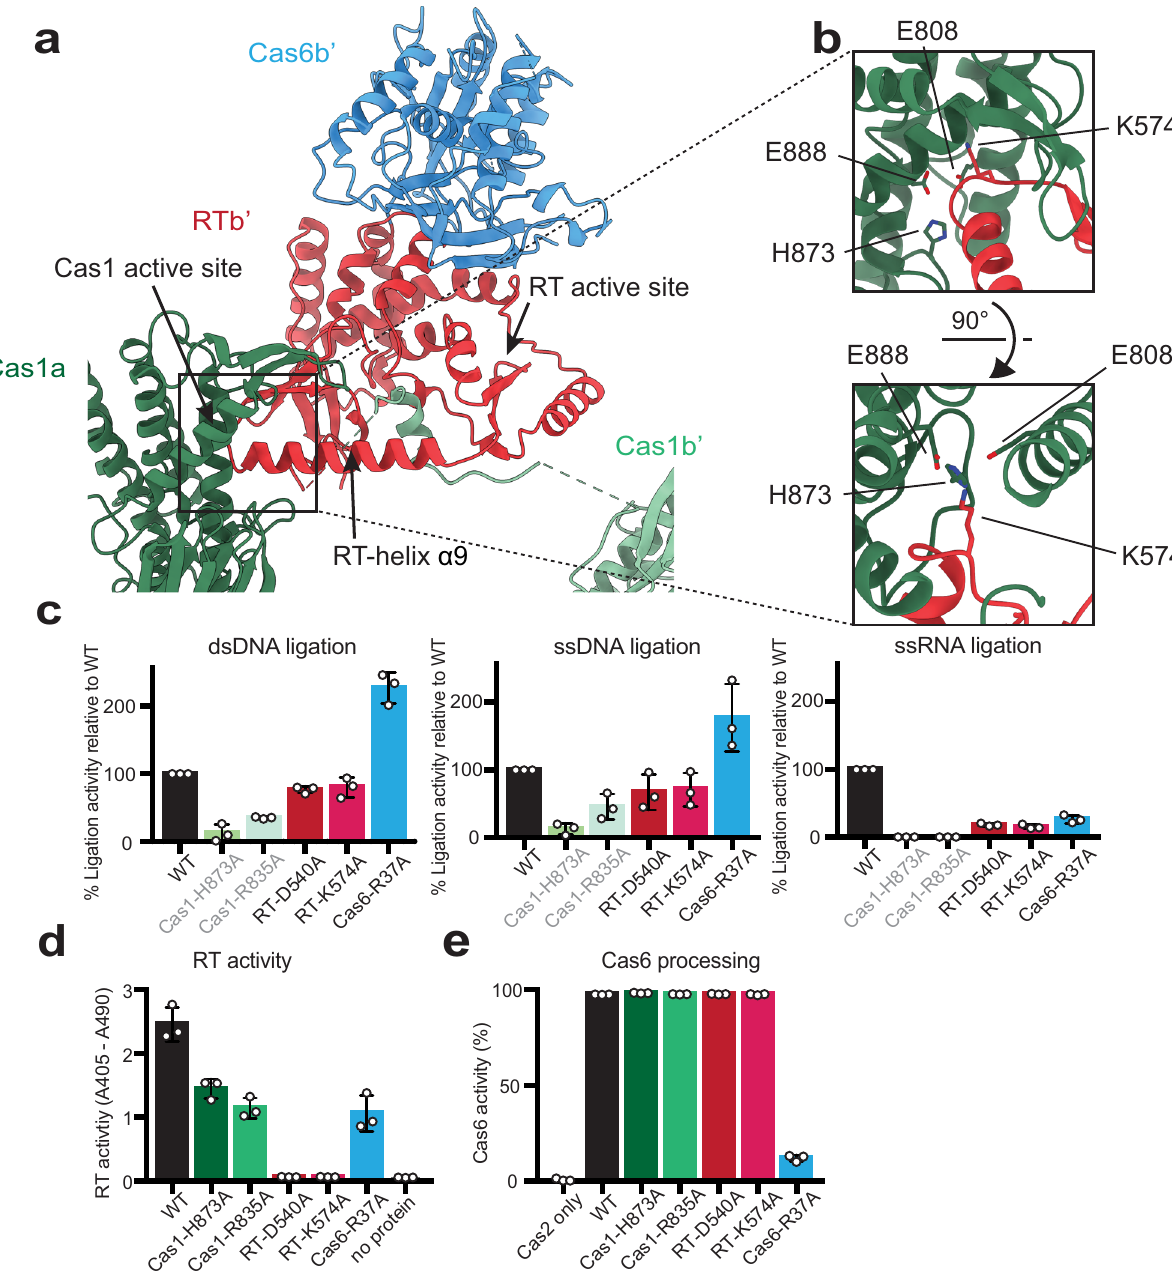
Fig. 6 Crosstalk between RT and Cas1 and Cas6 active sites. a Interaction between RT-helix α 9 and Cas1 active site (color-coding from Fig. 1). b Closeup of RT-helix in Cas1a and 90° rotation. Cas1 active site residues and RT-helix K574 are shown in stick con fi guration. c Ligation of fl uorescent 35-nt dsDNA (0.5 µ M), ssDNA (0.5 µ M), and ssRNA (4 µ M) protospacers into target pCRISPR by mutant Cas6-RT-Cas1 — Cas2s. The percent ligation activity is calculated as the fraction of fl uorescent products from the mutant complex relative to that from the WT complex (error bars, mean ± sd, n = 3 biologically independent experiments). Results are represented by colored bars: WT, black; Cas1 mutants, greens; RT mutants, reds; Cas6 mutant, blue. Cas1 mutant data are the same data shown in Fig. 2e and are depicted in pale greens with gray labels. Representative gels are shown in Supplementary Fig. 8c. d RT activity assays comparing the WT and mutant Cas6-RT-Cas1 — Cas2s (error bars, mean ± sd, n = 3 biologically independent experiments; Catalog No. 11468120910, Roche Diagnostics, Indianapolis, IN). Statistical signi fi cance was assessed by comparing samples to WT control using unpaired, two-tailed T tests ( α = 0.05) ( P = 0.0048, Cas1-H873A; P = 0.0019, Cas1-R835A; P = 0.0001, RT-D540A; P = 0.0001, RT-K574A; P = 0.0034, Cas6-R37A). Same color-coding is used from c except Cas1 mutant data are shown in darker greens with black labels. e Cas6 activity assays comparing the WT and mutant Cas6-RT-Cas1 — Cas2 proteins. The percent cleavage is calculated as the fraction of the fl uorescent CRISPR repeat RNA that has been cleaved, with color- coding from d (error bars, mean ± sd, n = 3 biologically independent experiments). A representative gel is shown in Supplementary Fig. 8e. Source data for panels c – e are provided as a Source Data fi